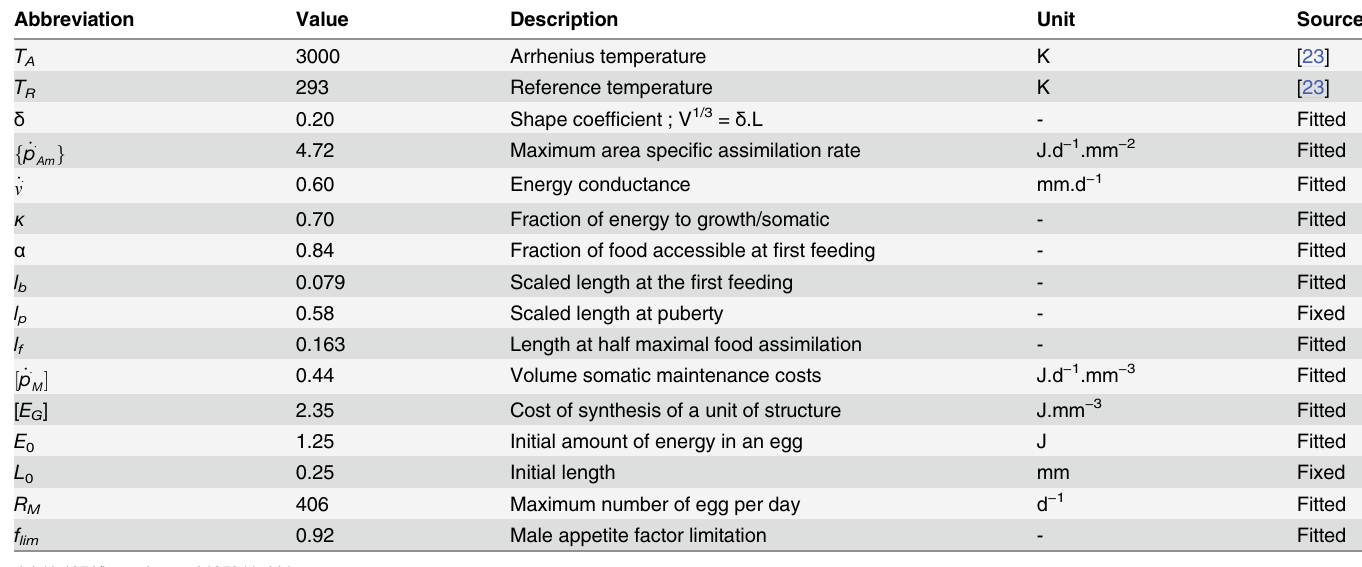
Table 1. Parameter abbreviations, values, descriptions and units of the DEB